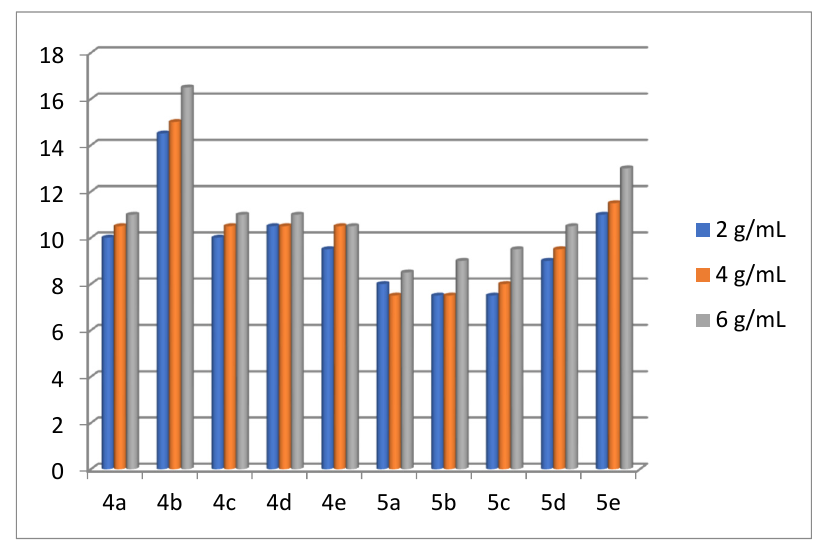
Figure 1. Graphical presentation of inhibition zone diameter (mm) against S. Aureus .